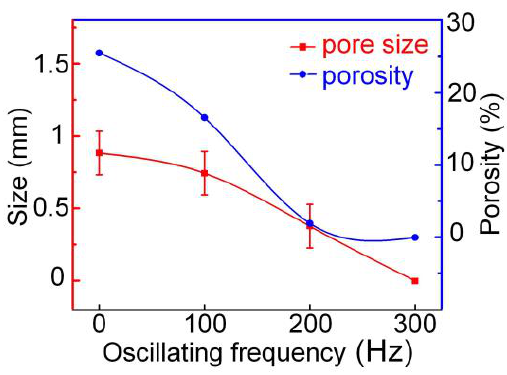
Figure 5. The relationship curves between pore size and porosity and oscillation frequency.